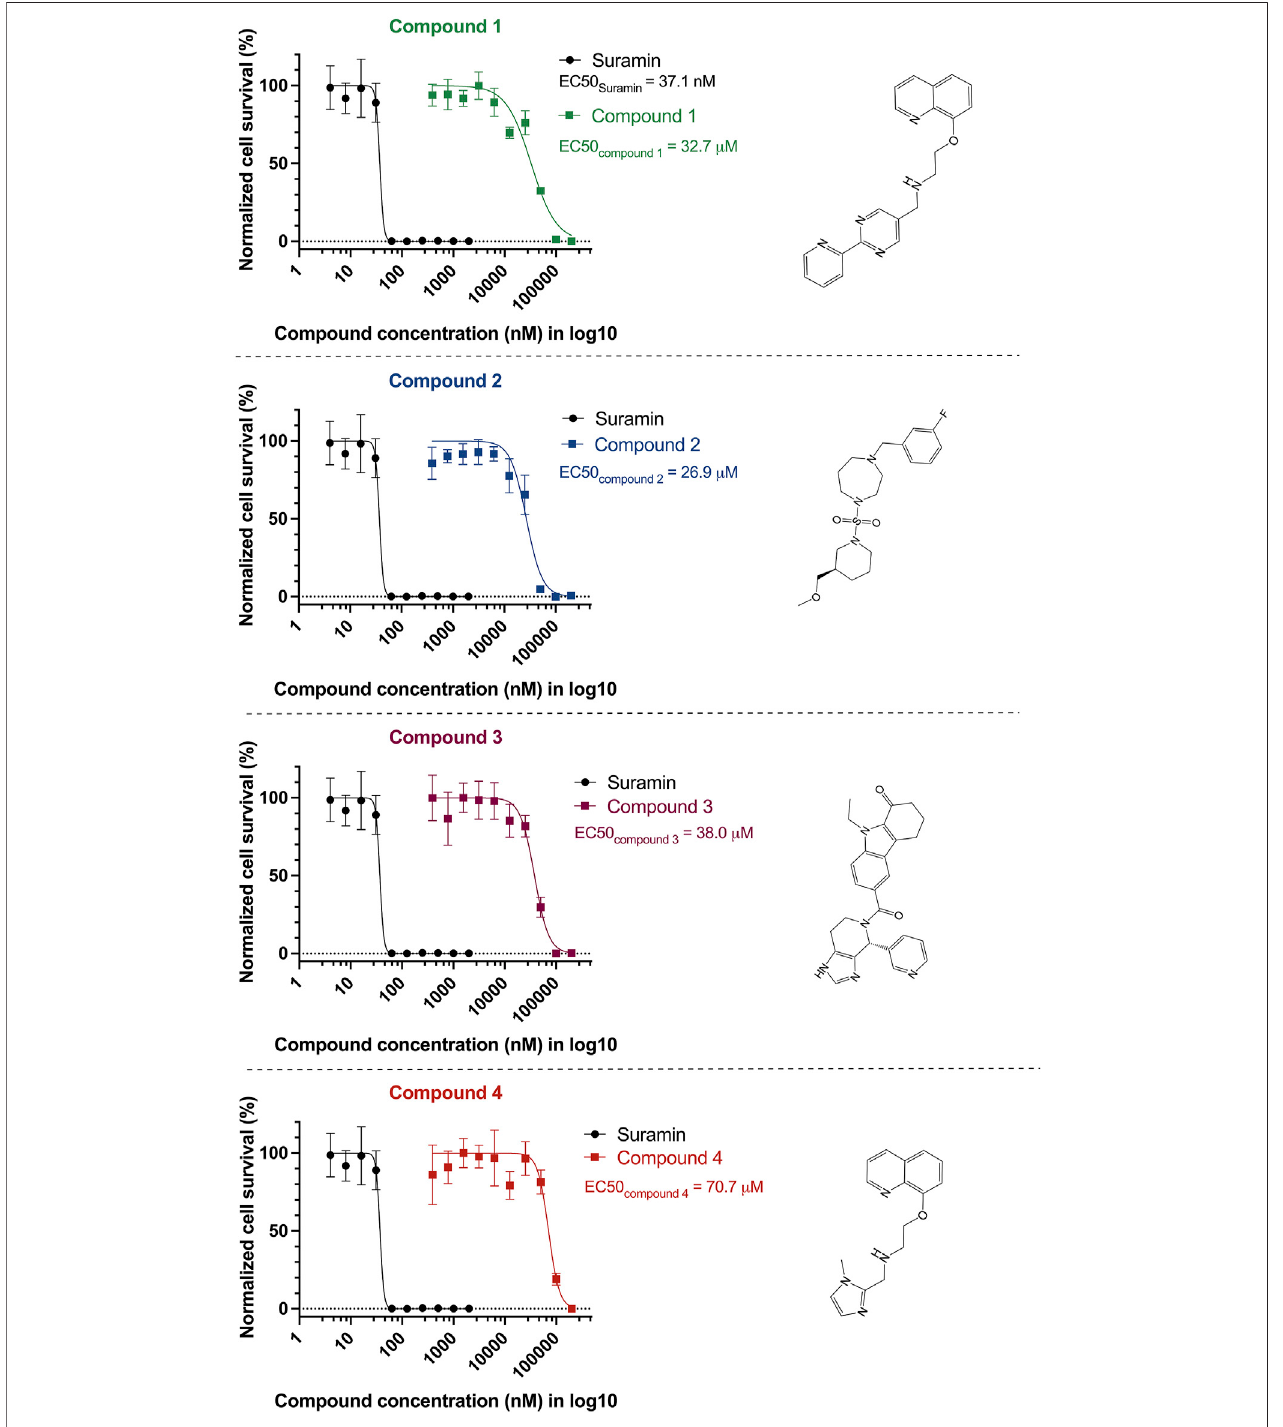
FIGURE5| Anti-trypanosomalactivityoftheinhibitors.Bloodstreamformofwild-type T.brucei parasites(BSF427)wastreatedwithserialdilutionsofPEX3 – PEX19 inhibitorsorsuraminasapositivecontrol.After3daysofincubation,cellviabilitywasestimatedusingresazurin-basedassay.Cellsurvivallevelsforallcompound-treated conditions were normalized and shown in percentage plotted against compound concentration in Log 10 scale, EC50 of suramin is 37 nM (black curve). Survival percentage for other compounds is drawn in curves of corresponding colors; the EC50 values of the four compounds are as follows: 33 μ M (compound 1 , green), 27 μ M(compound 2 ,navyblue),38 μ M(compound 3 ,purple),and71 μ M(compound 4 ,orange).Thecorrespondingstructureofthecompoundsisshown ontheright.